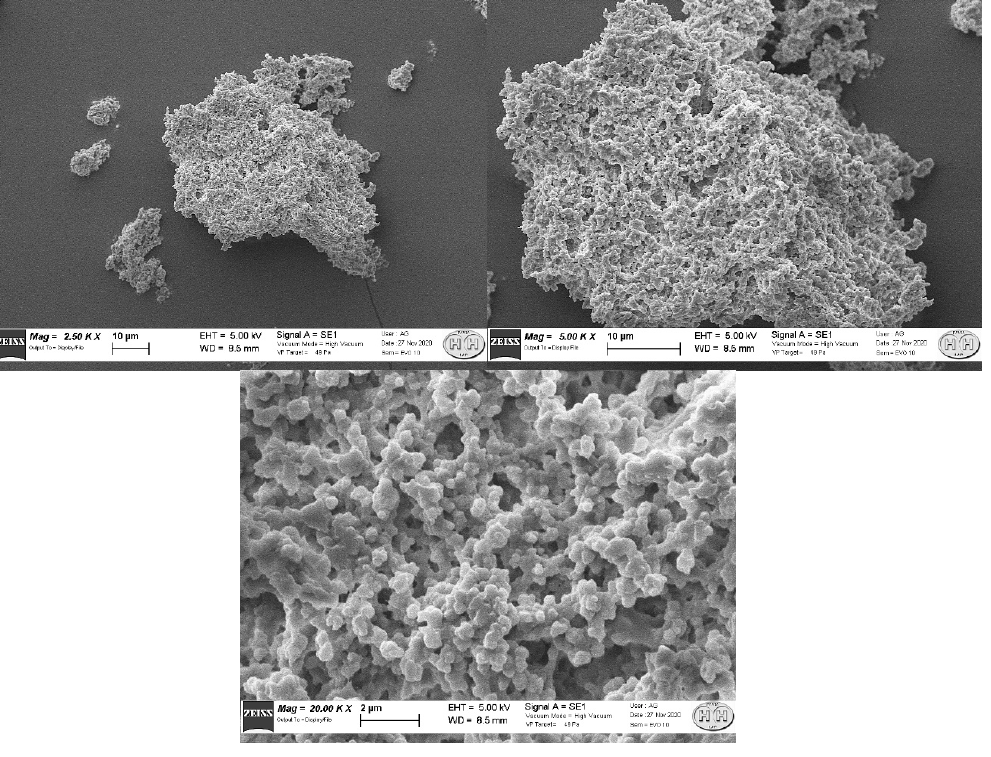
Figure 3. Successive enlargements of the first type of MAA structure (2.50 K ×, 10.00 K ×, 25.00 K ×).